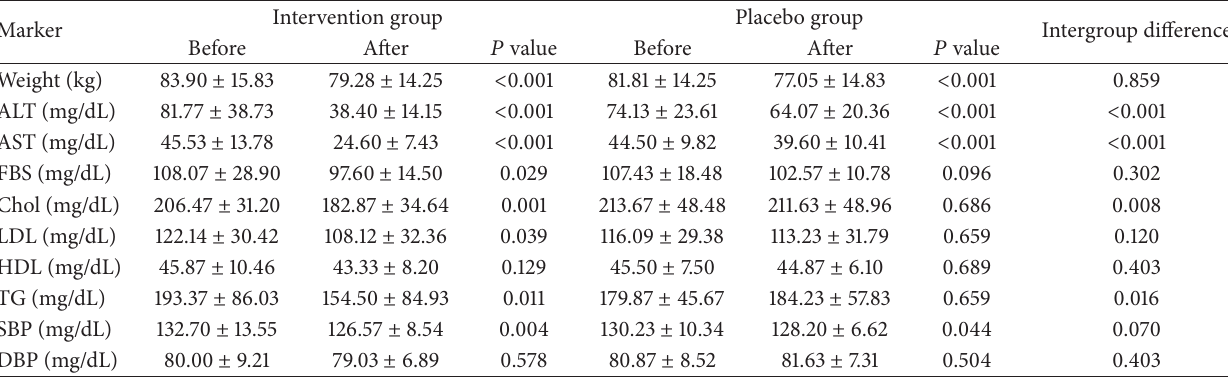
Table 1: Changes in study biomarkers in intervention and placebo groups.